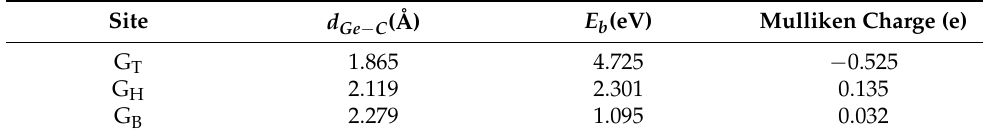
Table 1. The structural parameters of Ge-doped graphene.